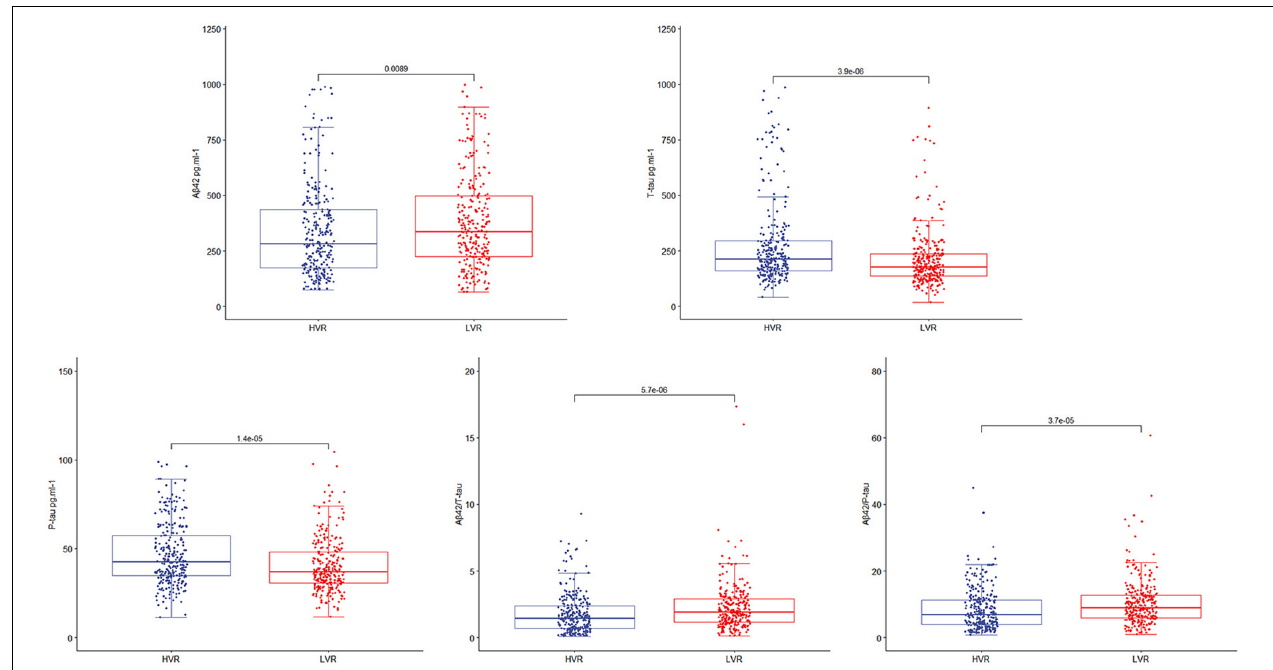
FIGURE 2 | The box-plots showed the level of CSF POD biomarkers in the higher vascular risk group (HVR) and the lower vascular risk group (LVR). The result showed that CSF T-tau and P-tau levels of the participants were higher in the higher vascular risk